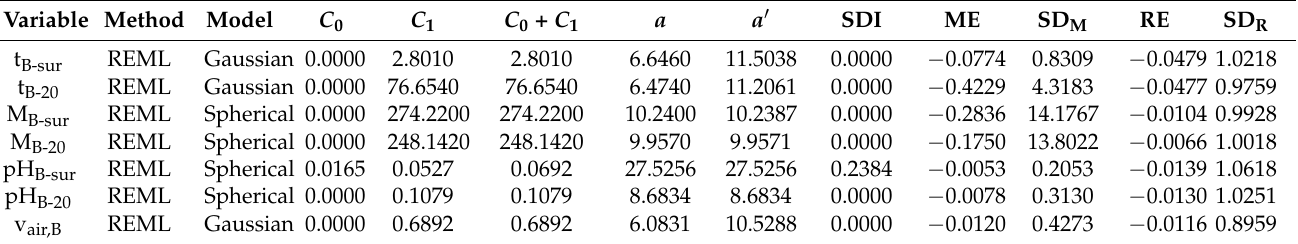
Table 1. Methods, models, and parameters estimated from the semivariograms adjusted for the mean values of bedding temperature at the surface (t B-sur ) and at the depth of 0.2 m (t B-20 ), bedding moisture at the surface (M B-sur ) and at the depth of 0.2 m (M B-20 ), bedding pH at the surface (pH B-sur ) and at the depth of 0.2 m (pH B-20 ) and air velocity at bedding level (v air,B ), during the experimental winter